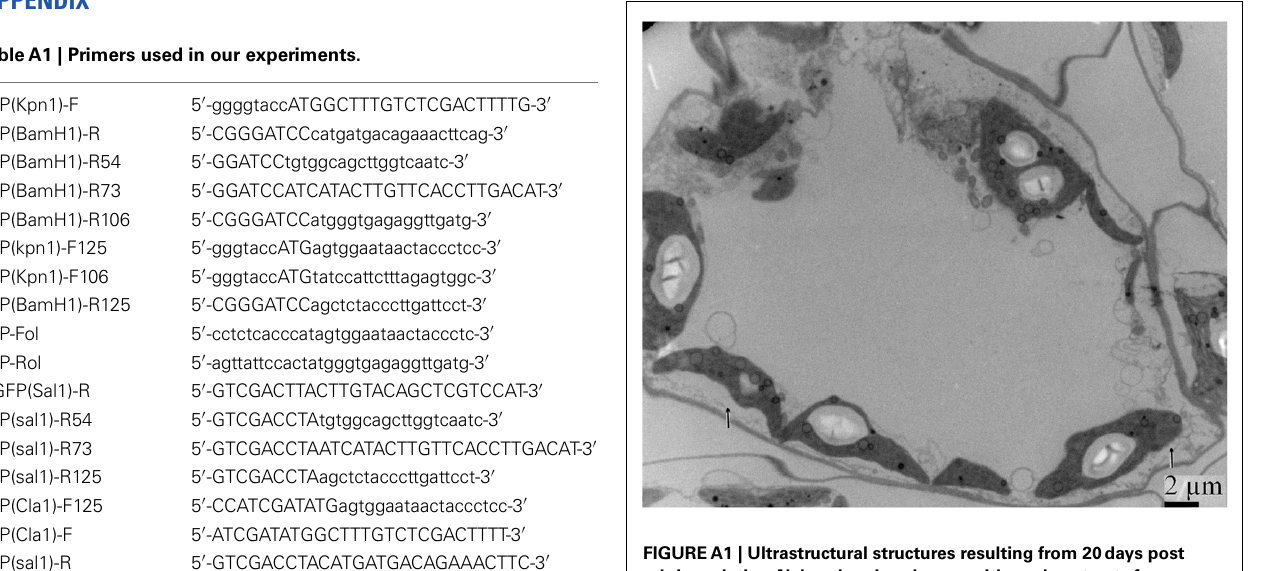
FIGUREA1 | Ultrastructural structures resulting from 20days post rub-inoculating N. benthamiana leaves with crude extracts from RSV-infected O. sativa leaves. Allows showed that membrane proliferations radiating from the chloroplasts into the